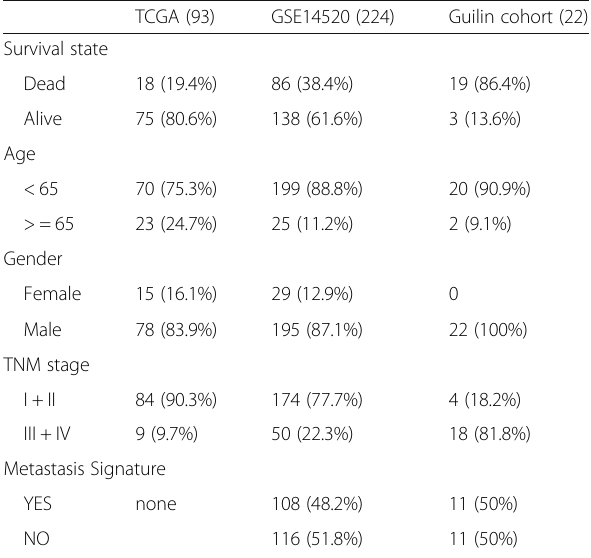
Table 1 Clinical characteristics of TCGA, GSE14520 and Guilin